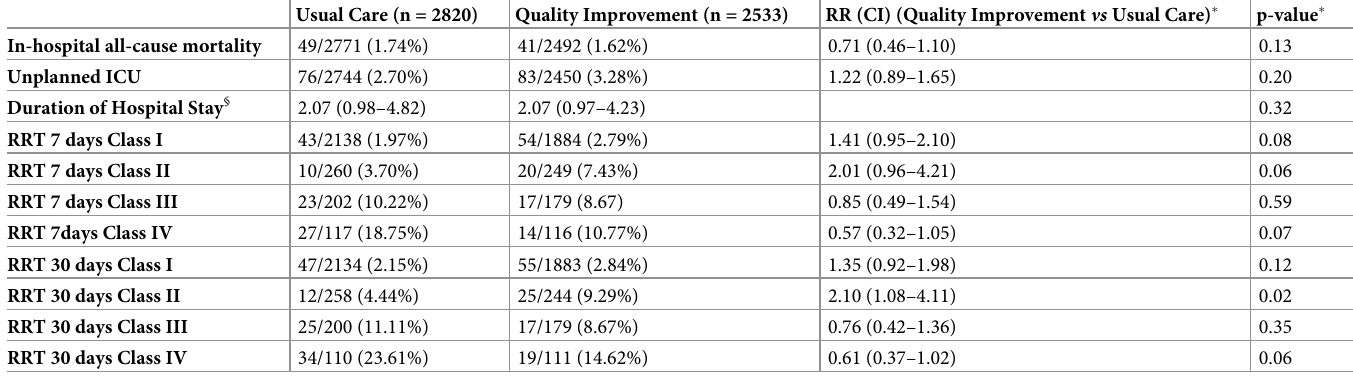
Table 3. Patient outcomes—in-hospital mortality, Unplanned ICU admission, RRT calls within 7 and 30 postoperative days, before and after the quality improve- ment program.